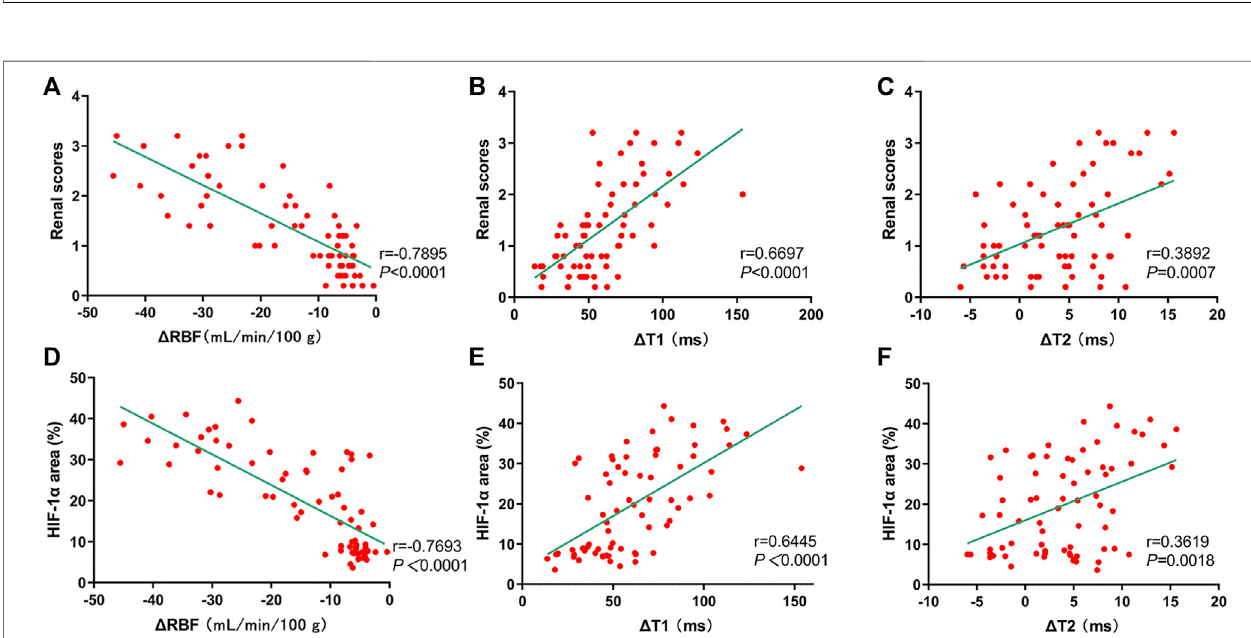
FIGURE 12 | Correlation of mpMRI with renal scores and HIF-1 α expression. (A – C) mpMRI vs. renal scores: (A) Δ RBF values, r = − 0.7895; (B) Δ T1 values, r = 0.6697; (C) Δ T2 values, r = 0.3892; (D – F) mpMRI vs. HIF-1 α : (D) Δ RBF values, r = − 0.7693; (E) Δ T1 values, r = 0.6445; (F) Δ T2 values, r = 0.3619.